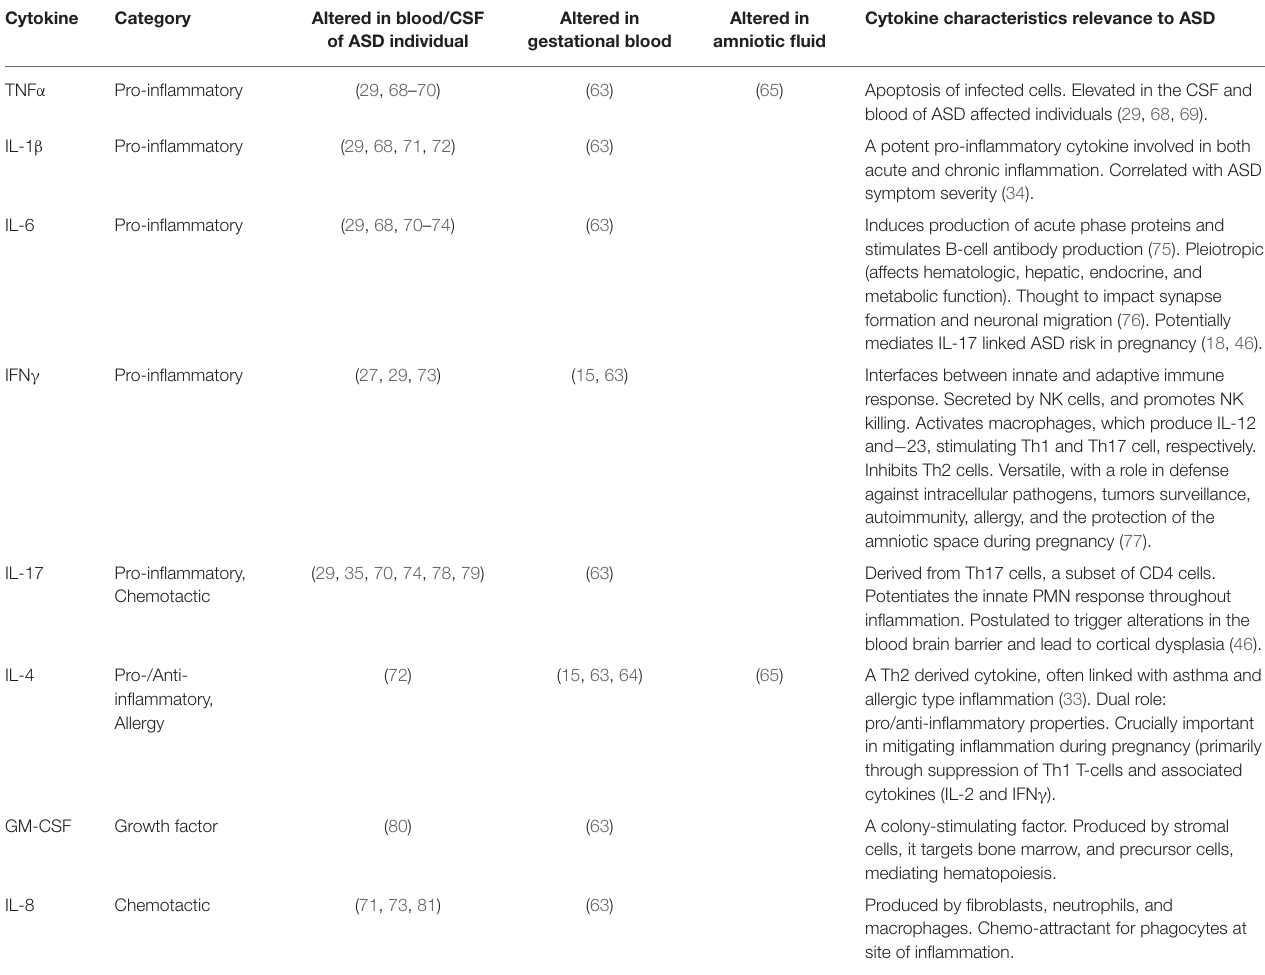
TABLE 1 | Cytokine dysregulation in ASD affected individuals and in gestational serum and amniotic fluid samples of mothers with ASD affected offspring. Cytokine